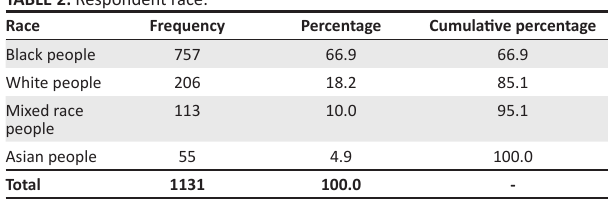
TABLE 2: Respondent race.